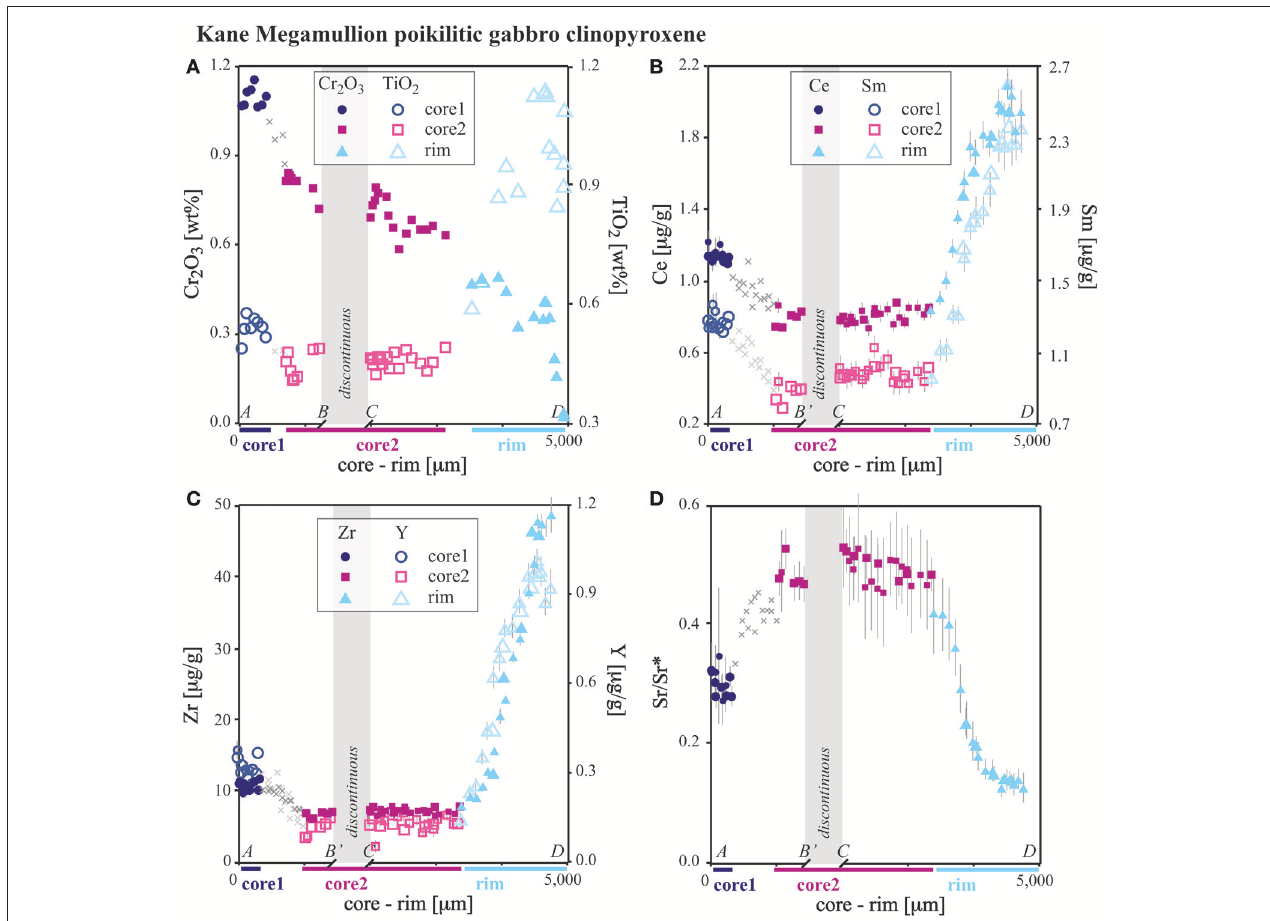
Figure 3 | Chemical variations across a zoned clinopyroxene in Hess Deep lower oceanic crust poikilitic gabbro: (A) Cr 2 O 3 and TiO 2 , (B) Ce and Sm, (C) Zr and Y and (D) Sr/Sr*. See profile locations in Figures 2A,B (core1 KM -core2 KM : A,B [B’], core2 KM -rim KM -outer rim KM : C,D). Overgrown core2 KM is depleted in compatible Cr 2 O 3 , moderately incompatible TiO 2 , HREE (e.g., Sm) and Y and strongly incompatible LREE (e.g., Ce) and Zr. Core2 KM shows higher Sr/Sr* ratio than in anhedral core1 KM (see other elements in Table A.1 ). The associated dissolution texture and chemical zoning are best explained by assimilation of a gabbroic assemblage and recrystallization from basalt-gabbro hybrid melt. Late-stage outer rim KM shows strong TiO 2 , REE, Y and Zr increases and Cr 2 O 3 , Sr/Sr* (and Mg#) decreases. Gray crosses are non-plateau analyses, partly reequilibrated upon diffusion. Large symbols are LA-ICP-MS 51 µ m spot analyses. 1 σ error bars are shown for trace elements. Data in Table A.1